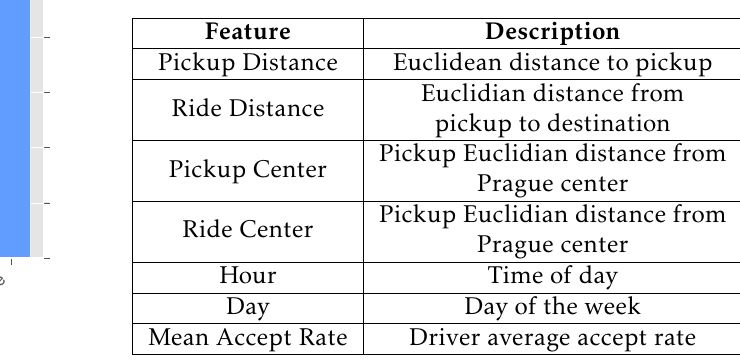
Table 2. Features derivedfromthe